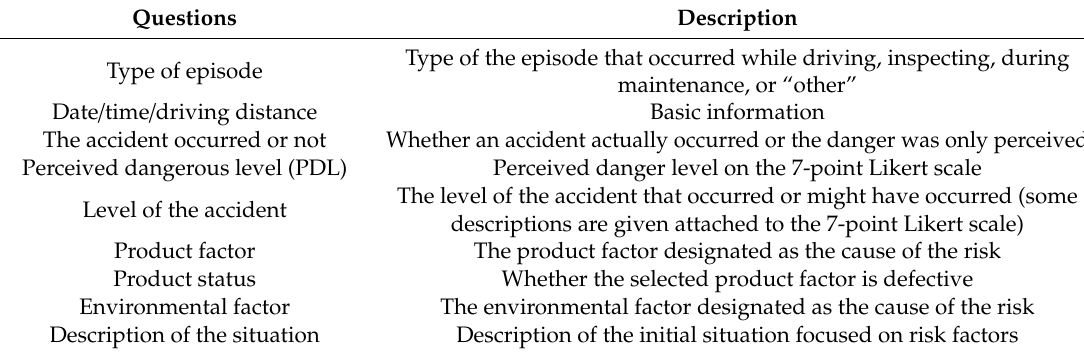
Table 2. Questionnaire